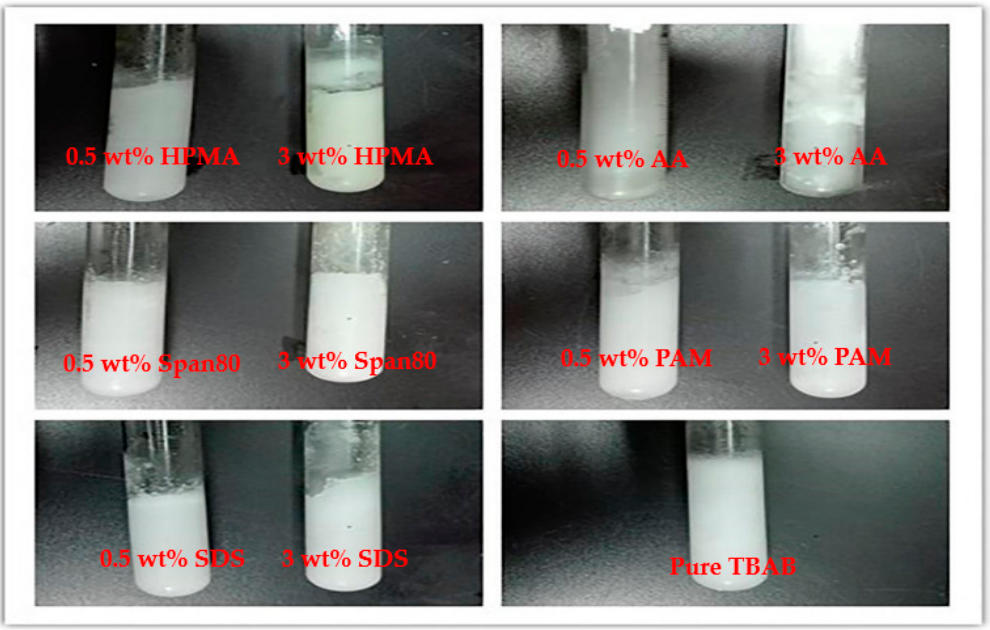
Figure 1. Photograph of Tetrabutylammonium bromide (TBAB) hydrate with different anti-agglomerants after 1.5 h.